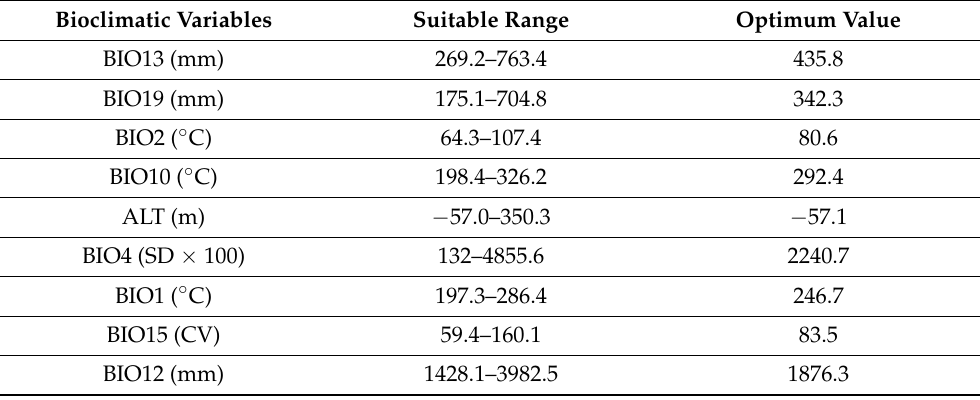
Table 5. Suitable range of bioclimatic variables for the potential distribution of Microplitis manilae